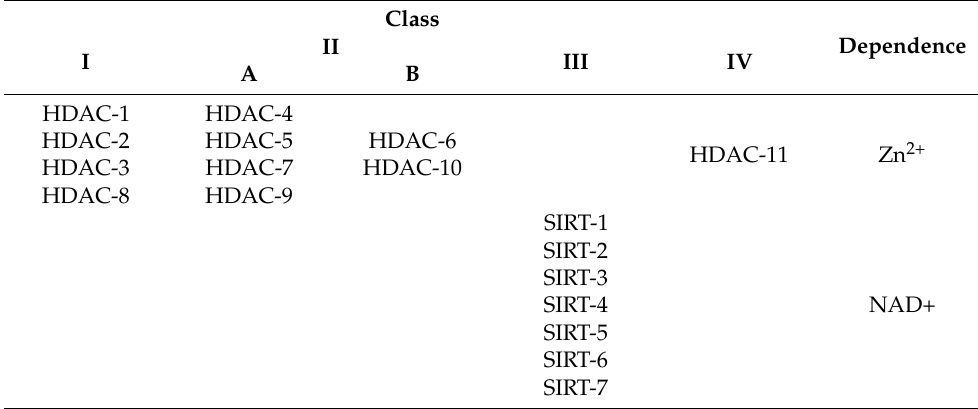
Table 1. Classification of histone deacetylases.